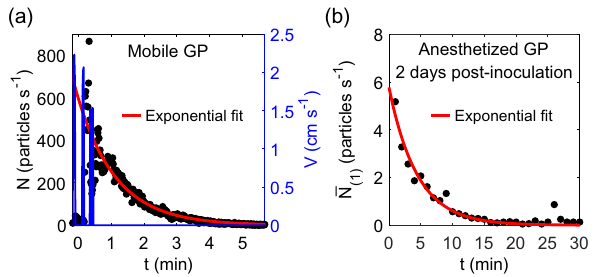
Figure 5. Representative particle emission rate dynamics ( a ) after a guinea pig stops moving in a cage with CC bedding, and ( b ) after placing the aluminum sleeve containing an anesthetized guinea pig inside the measurement cage. In ( a ), the blue lines are the animal velocity. In both ( a ) and ( b ), the red lines are best fits to − kt an exponential decay of the form N = N 0 e with k = 0.85 min −1 for ( a ) and 0.22 min −1 for ( b